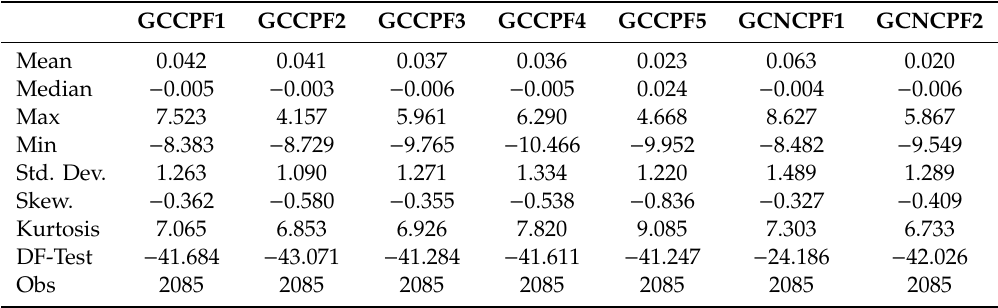
Table 4. Descriptive statistics of the excess returns of Greater China funds under the CPF Investment Scheme and non-CPF Greater China funds.